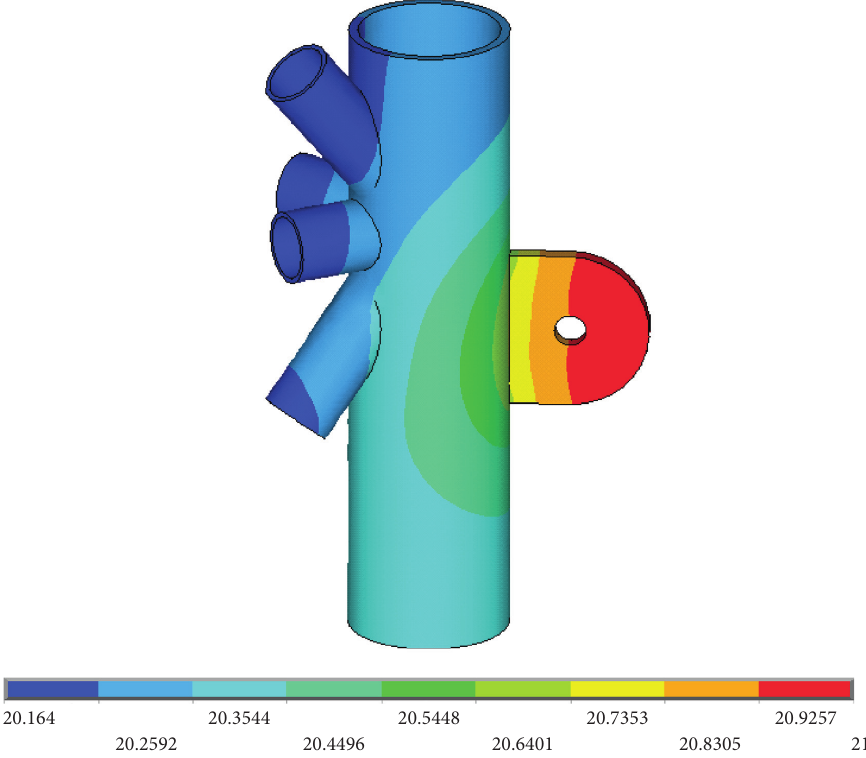
20.164 Figure 7: Distribution of the temperature